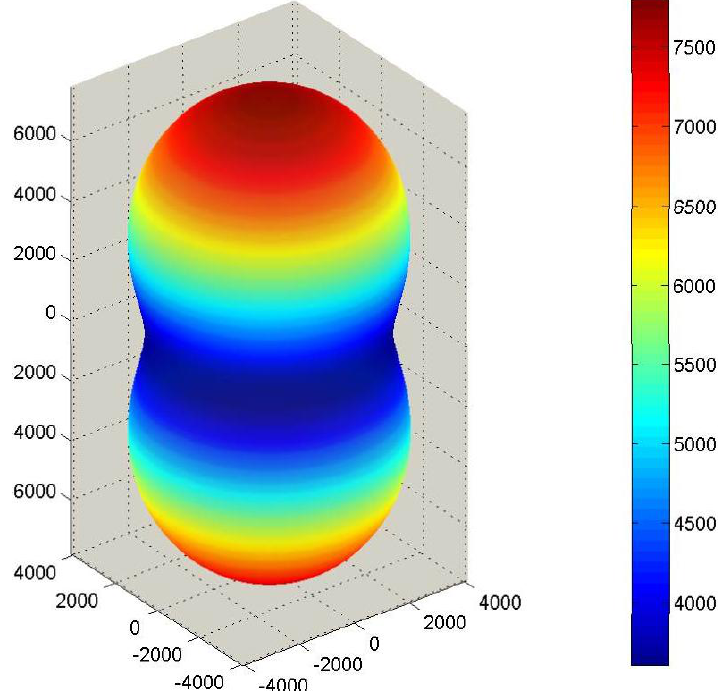
Figure 3. Longitudinal surface representation, K T ( h ), for the dielectric constant of a PMN-PT single